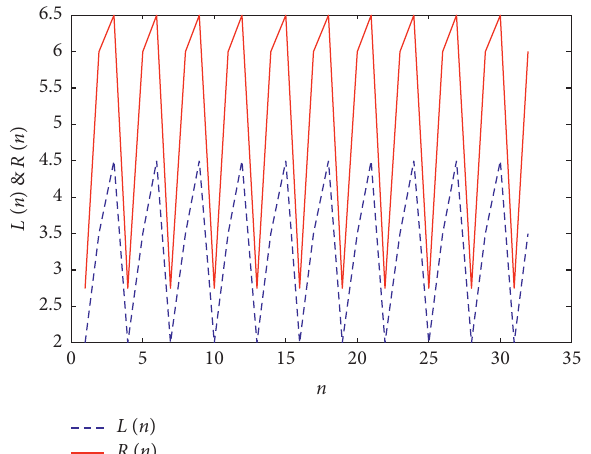
Figure 2: The solution of system (85) when α � 0 . 5.